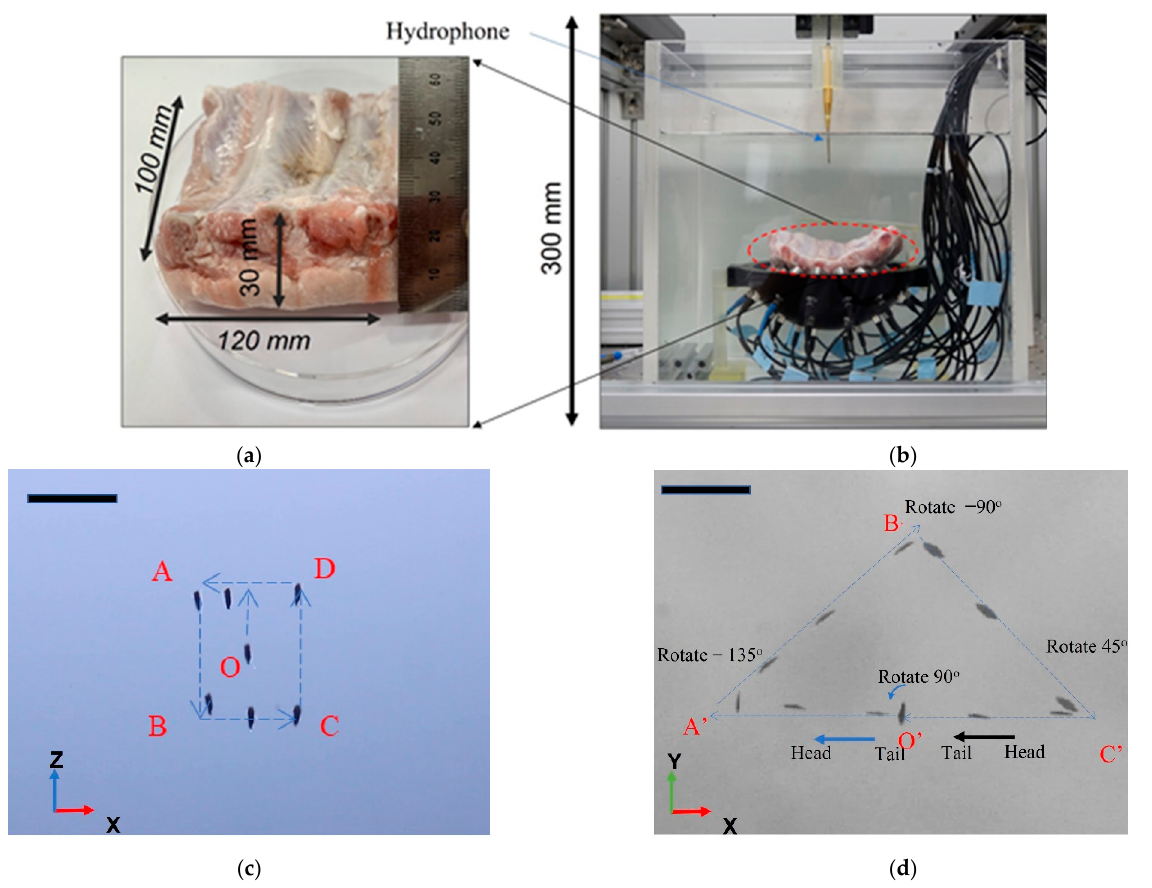
Figure 12. Ex vivo experiments for testing the manipulation and rotation of nanocarrier cluster: ( a ) Porcine rib dimension; ( b ) Experimental setup; ( c ) Time ‐ lapse images of the manipulation in the ( a ) Porcine rib dimension; ( b ) Experimental setup; ( c ) Time-lapse images of the manipulation in the XOZ XOZ planes; ( d ) Time ‐ lapse images of the manipulation and rotation in the XOY plane (scale bar: 2 planes; ( d ) Time-lapse images of the manipulation and rotation in the XOY plane (scale bar: 2 mm).